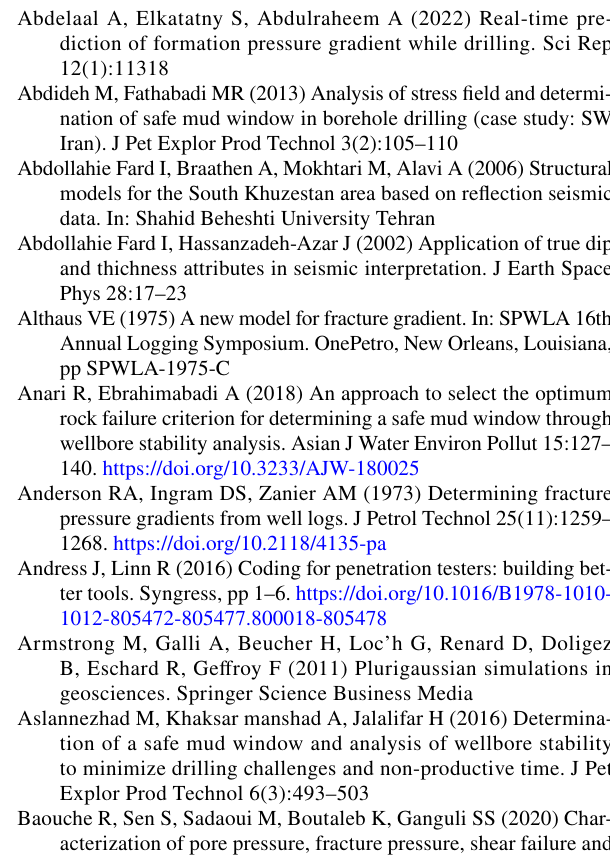
Fig. 21 General histogram of a minimum, b maximum, and c changes in mud weight based on the pressure model of the South Azadegan